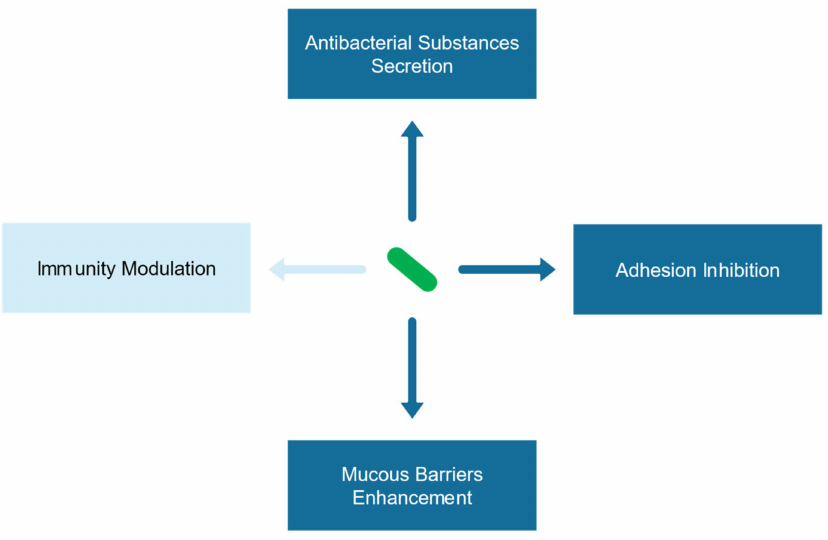
Figure 2. Antagonistic mechanism of probiotic against H. pylori